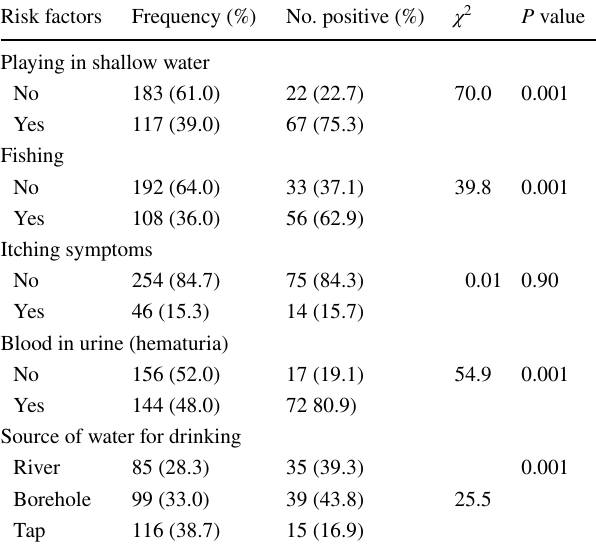
Table 2 Frequency of risk factors associated with urinary schistoso- miasis among primary school children in Zaki, Nigeria Risk